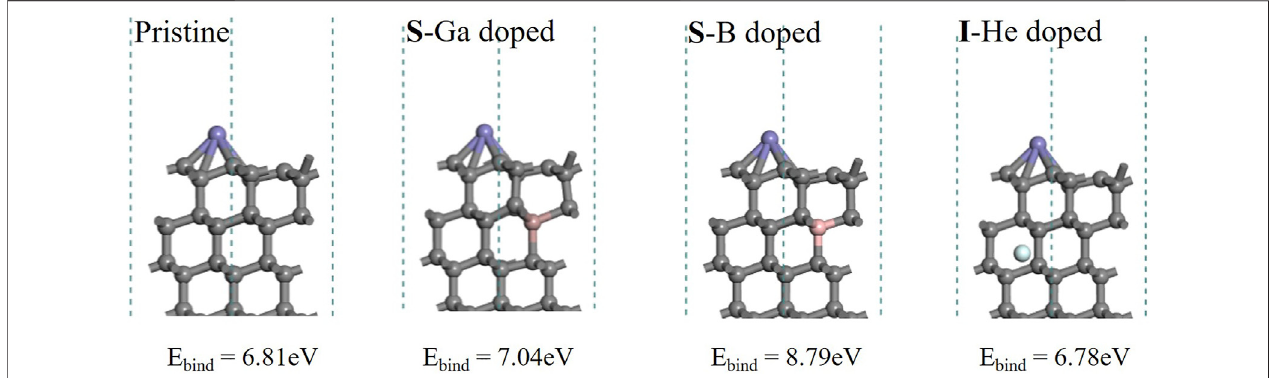
FIGURE 7 | Optimized structures of adsorption con fi gurations with Fe atoms on pristine and doped diamond (111) surfaces.